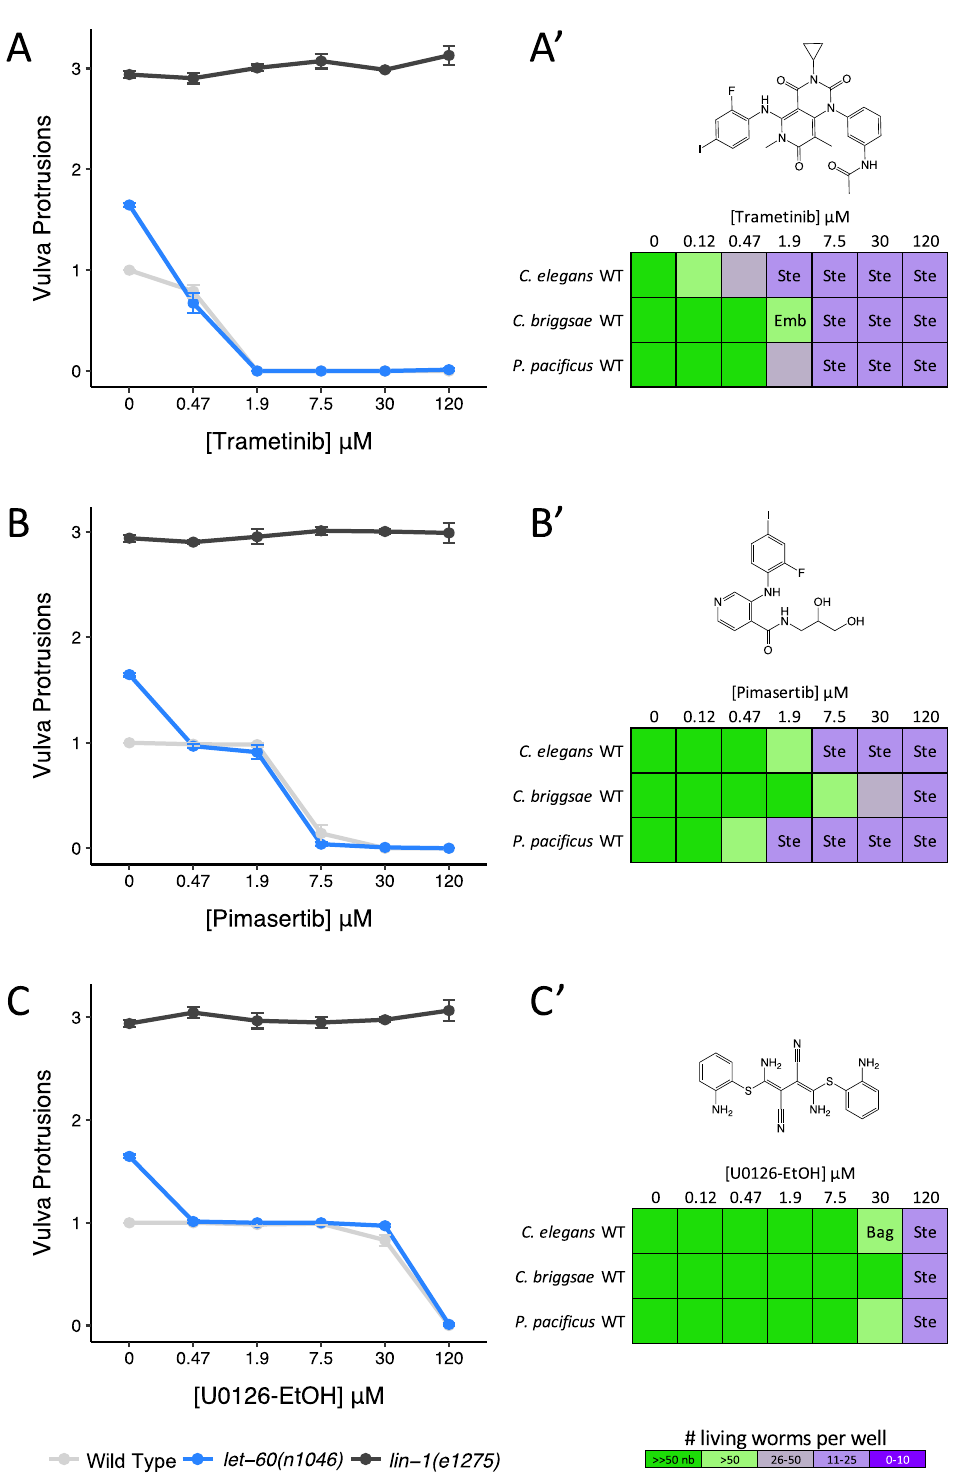
Figure 7. Vertebrate allosteric MEK inhibitors target worm MEK-2, inducing loss-of-function phenotypes across nematode species. ( A – C ) Three structurally distinct allosteric MEK inhibitors suppress the Multivulva phenotype of upstream let- 60(n1046) gain-of-function mutants, but have no effect on the Multivulva phenotype in downstream lin-1(e1275) loss-of- function mutants. The average number of vulva protrusions observed per worm in each condition quantified over 3 biological replicates is shown. Error bars indicate SEM. ( A ′ – C ′ ) Phenotypes induced by allosteric MEK inhibitors in free-living nematode species C. elegans, C. briggsae and P. pacificus. Sterility (Ste), embryonic lethality (Emb) and bag-of-worms (Bag) phenotypes are reported along with the resulting population growth defects indicated by the colour coded scale (nb, no bacteria remaining in the